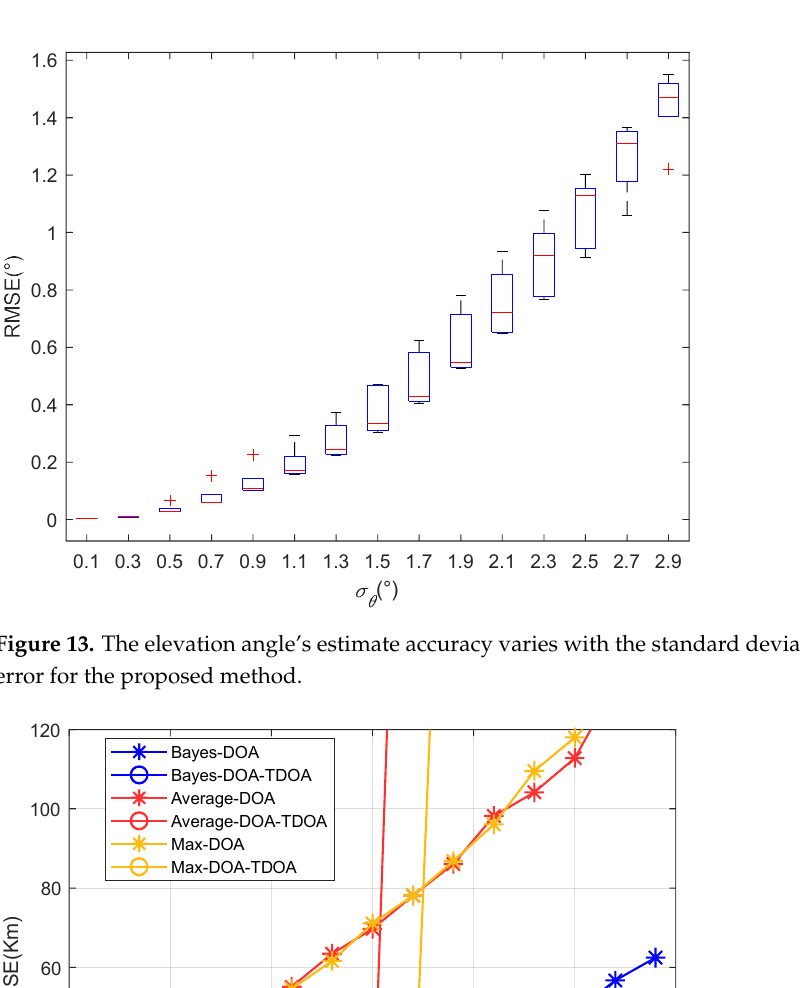
Figure 12. The elevation angle’s estimate accuracy varies with the angle’s standard deviation for the traditional methods.